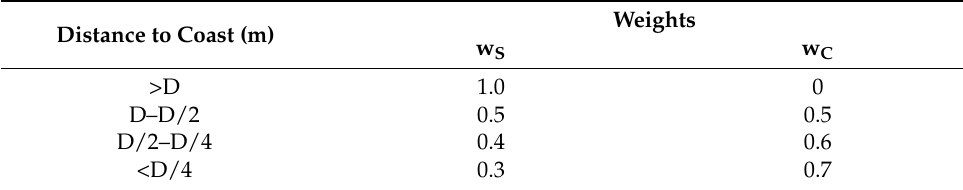
Table 12. Weights according to distance to the